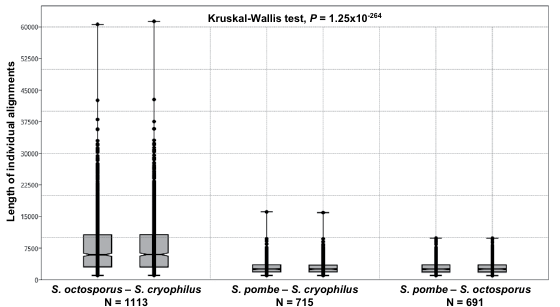
Figure 4. Length distributions of individual DNA alignments created by YASS 50 (E = 0). Box plots indicate the 25–75 percent quartiles. Horizontal lines within the boxes show the medians of the samples, notches indicate the 95 percent confidence intervals for the medians. Minimal and maximal values are depicted by the whiskers, plots on the whiskers show individual values. N: sample size. Alignments of S. octosporus-S. cryophilus are significantly different from the other alignments (Kruskal-Wallis test, P = 1.25 × 10 − 264 ). Pairwise statistics (Mann-Whitney U tests) are presented in Supplementary Table 3.